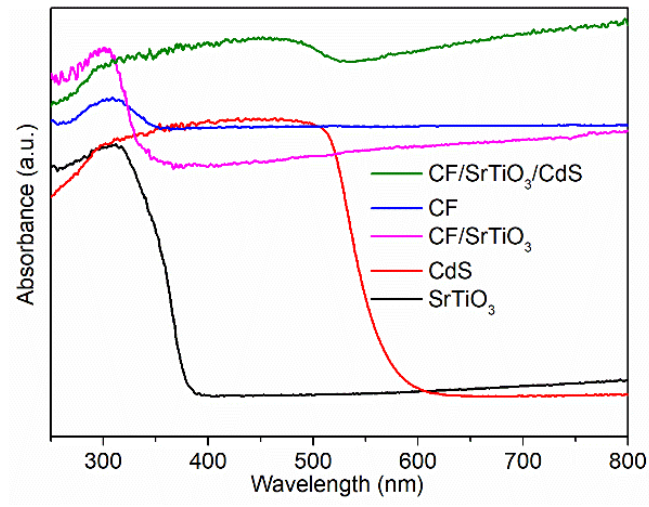
Figure 10. UV–vis diffuse reflection spectra of samples.